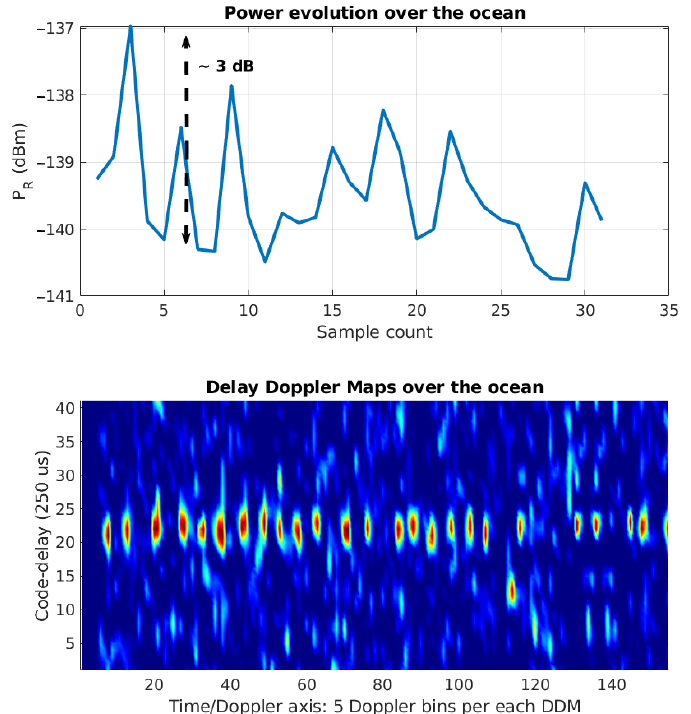
Figure 16. Received power and Delay-Doppler Map (DDM) track for the selected track near Iceland, collected on the 10 October